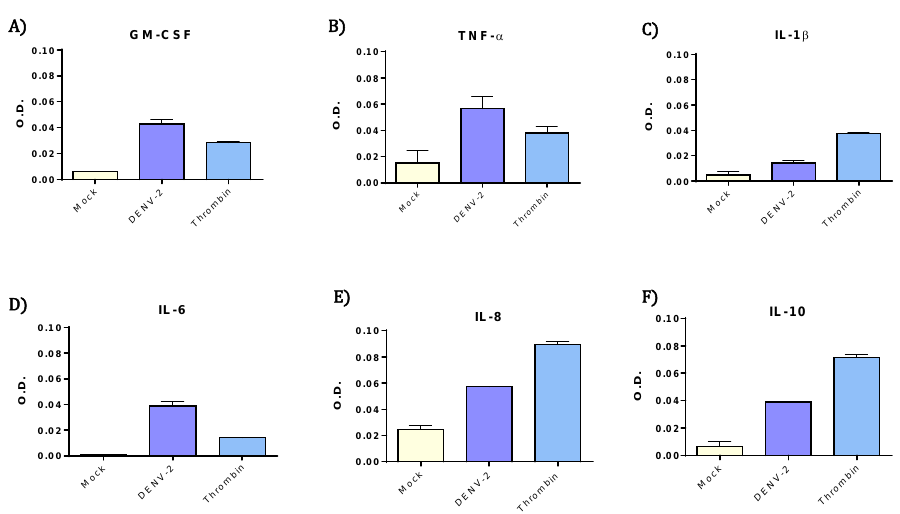
Figure 3. Higher levels of TNF- α , IL-6, IL-8, GM-CSF, and IL-10 were released from DENV-2 exposed platelets. Cytokines and chemokines were evaluated, two pools from six supernatants for each experimental group. Original supernatants were obtained from 3 × 10 8 /mL human platelets after 4 h of stimulation with DENV-2 (MOI 0.2), mock or thrombin. Cytokines were measured by optical density GM-CSF ( A ); TNF- α ( B ); IL-1 β ( C ); IL-6 ( D ); IL-8 ( E ) and IL-20 ( F ) at 450 nm. TNF- α , IL-8, GM-CSF, and IL-10 were elevated after DENV-2 incubation. IL-6 showed to be more elevated than thrombin control, and IL-1 β only showed a small increment. Since each bar contains values of only two pools, only standard deviation is shown. No statistical analysis was performed on these data.